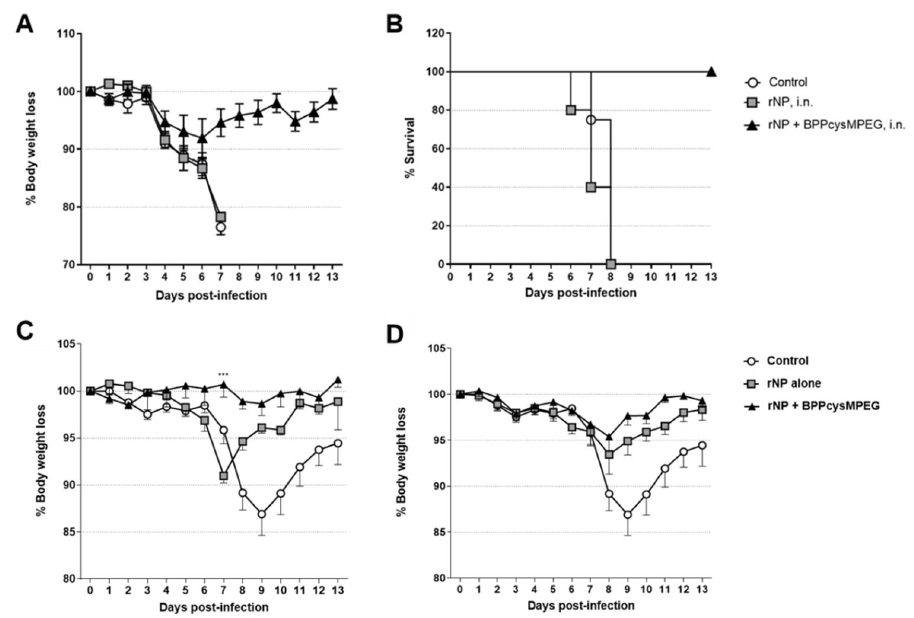
Figure 5. Protection of mice vaccinated with the formulations against influenza A virus infection. Vaccinated BALB/c mice groups were challenged with a lethal dose of the homologous influenza strain A/Puerto Rico/8/34 (H1N1) on day 60. Bodyweight loss in percentage ( A ) and survival rates ( B ) were measured after lethal challenge for a period of two weeks. SEM are indicated by vertical lines. Vaccinated BALB/c mice groups were challenged with a sublethal dose (10 3 ffu) of the homosubtypic influenza strain A/Puerto Rico/8/34 (H1N1) on day 60 by the i.n. ( C ) or the s.c. ( D ) route. Bodyweight loss was measured daily after challenge for a period of two weeks. SEM are indicated by vertical lines. Statistical analysis between the adjuvanted and non-adjuvanted groups was performed by two-tailed Student’s t -test. Differences were statistically significant (***, p < 0.001) compared to